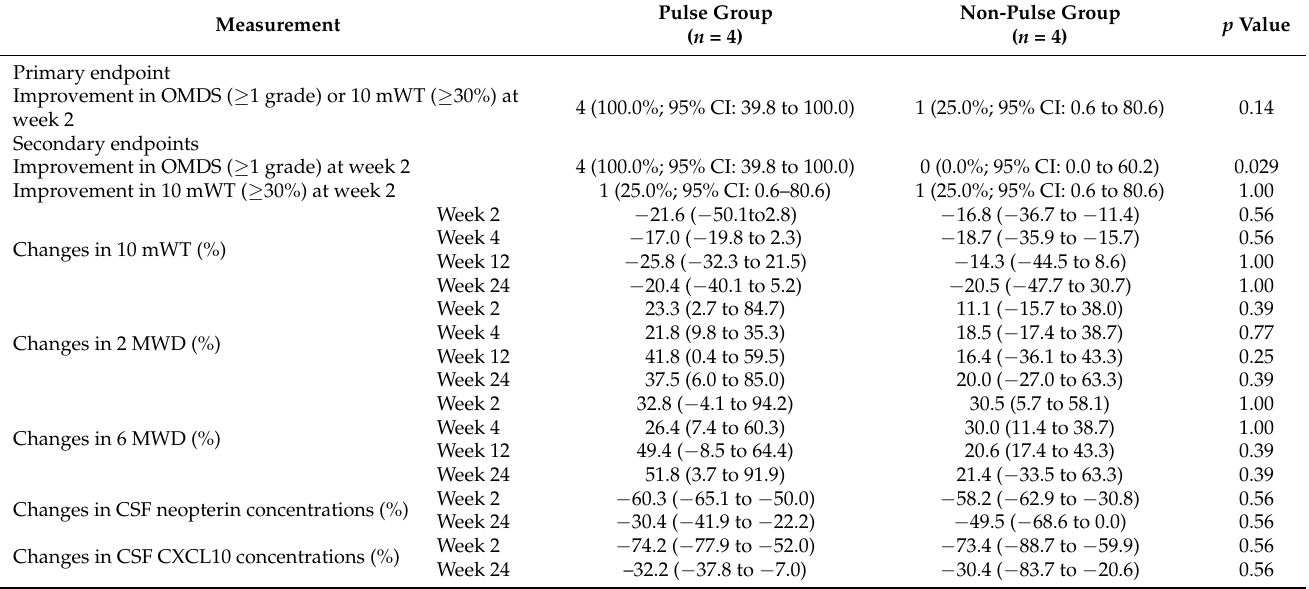
Table 3. Main outcomes in rapid